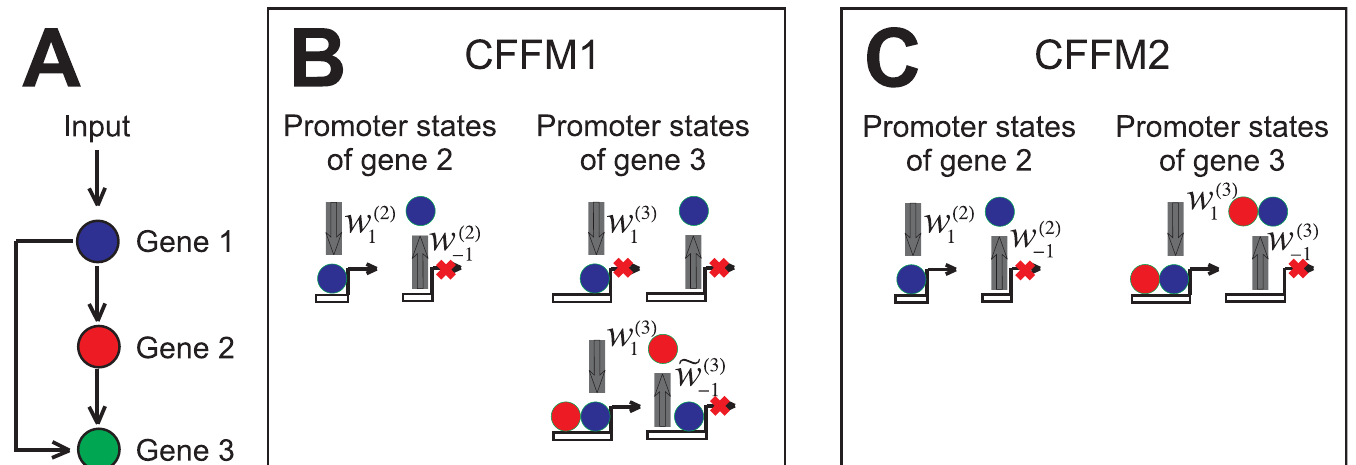
Fig 5. Two types of the coherent feed-forward motif. A) A schematic of the CFFM. The transcription factor of gene A (TFA) enables transcription of gene B, and TFA and TFB together enable transcription of gene C. B) First, TFA binds to the promoter of C; then, either it dissociates or TFB binds to the promoter next to TFA. TFB can bind to the promoter only when TFA is already there. Only when TFA and TFB are both in place can transcription of gene C be initiated. C) TFA and TFB form a heterodimer which then binds the promoter of gene 3, initiating its